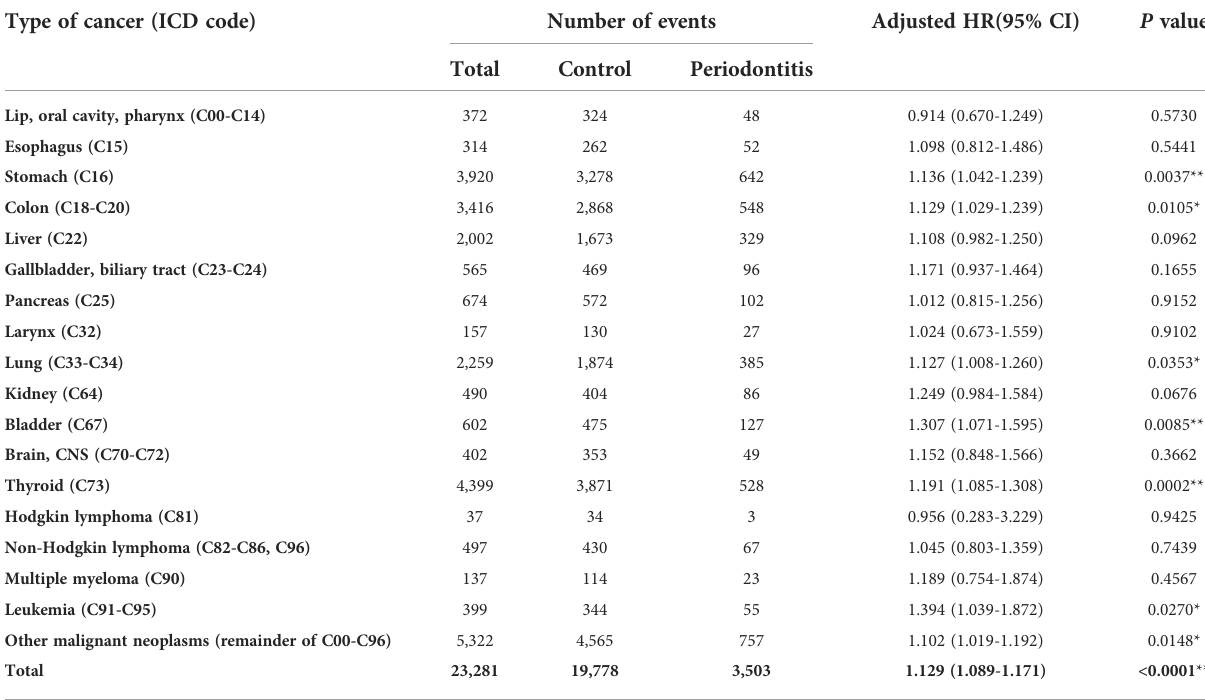
Table 2 Adjusted risks of total and organ-speci fi c cancers in patients with periodontitis after correcting confounding factors. Type of cancer (ICD code)